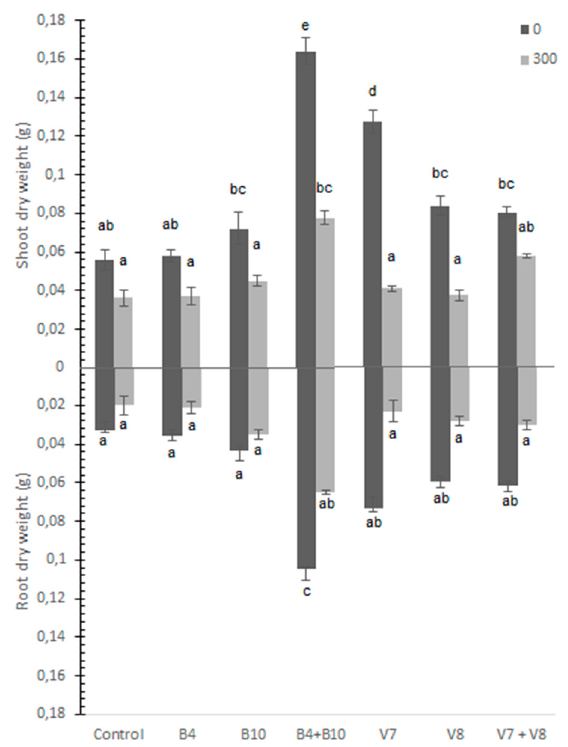
Figure 1. Shoot and root dry biomass of Triticum aestivum grown in a soil supplemented with 300 mg·Kg − 1 of As and inoculated with Pseudomonas gessardii (B4), B. intermedia (B10), the mixture of both (B4 + B10), F. rabenhortii (V7), H. viticola (V8), and the mixture of both (V7 + V8). The standard deviation is indicated by different bars and letters show statistically significant differences ( p < 0.05).